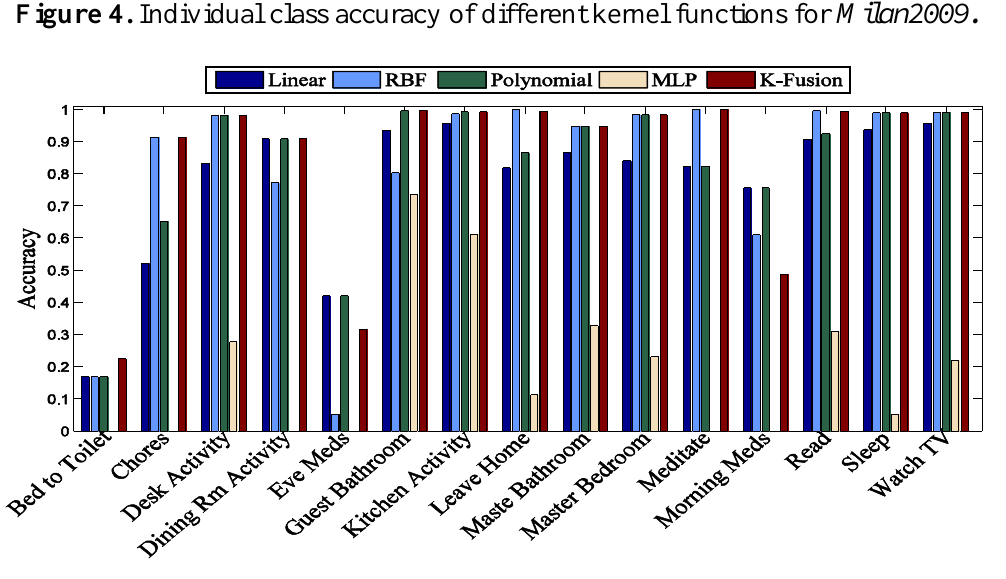
Figure 5. Individual class accuracy of different kernel functions for